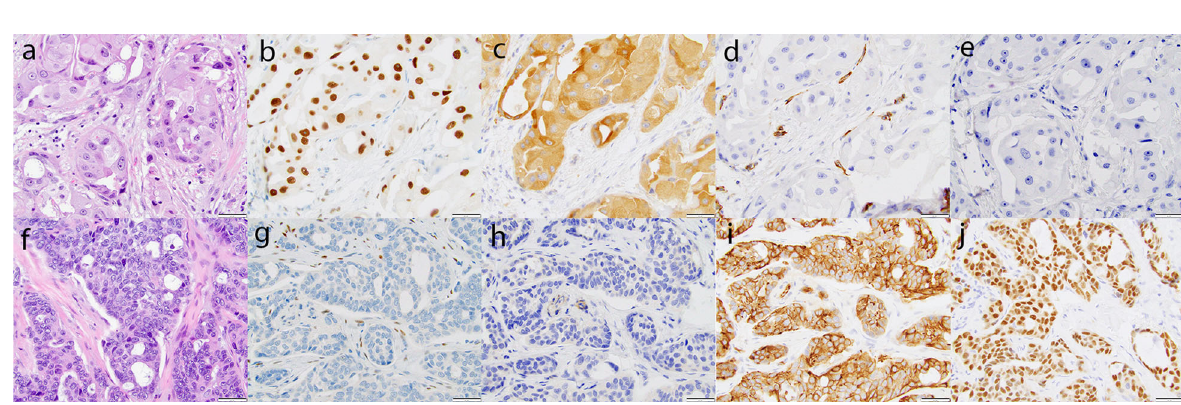
Fig. 4 Immunohistochemical expression of luminal and basal markers. An apocrine carcinoma ( a ) showing diffuse-strong reactivity for AR ( b ) and INPP4B ( c ) but is negative for nestin ( d ) and SOX10 ( e ) while this no special type TNBC ( f ) is negative for AR ( g ) and INPP4B ( h ) but positive for nestin ( i ) and SOX10 ( j ). Scale bar = 50